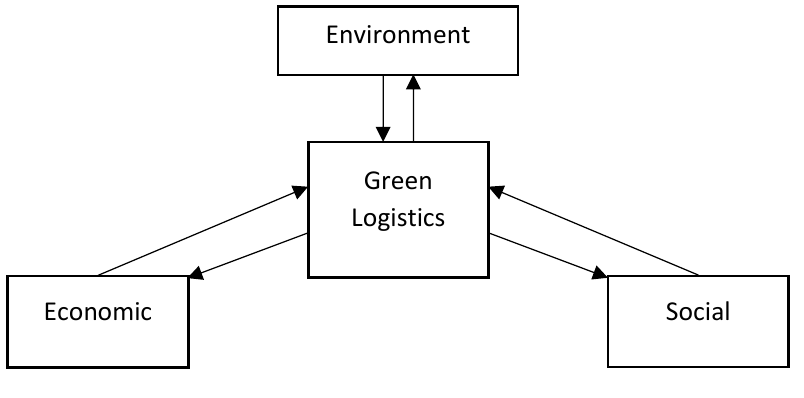
Figure 1: Green Logistic is a factor of sustainable development